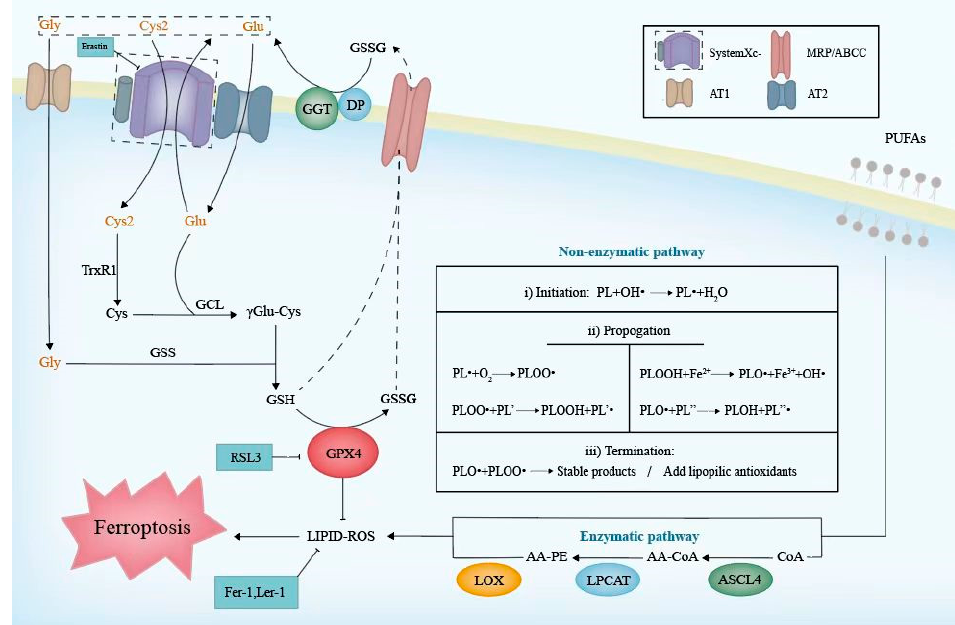
Figure 2. The molecular mechanism of the Cyst(e)ine/GSH/GPX4 axis and lipid peroxidation. The left side of the figure indicates a series of enzymatic reactions for GSH synthesize. As a cofactor for GPX4, GSH could be oxidized to GSSG. Excessive GSH and GSSG could be transported extracellularly. The box on the top right indicates the transporters on the cell membrane. The GPX4 reduces lipid ROS which contributes to the inhibition of lipid peroxidation. The right part depicts the non-enzymatic and enzymatic pathways of lipid peroxidation. The table lists three non-enzymatic phases including initiation, propagation and termination. ACSL, LPCAT3, and LOX are the key enzymes of enzymatic pathways. GSH, glutathione; GCL, γ -Glu-Cys ligase; GSS, glutathione synthetase; MRP/ABCC, multidrug resistance-associated protein; GGT, γ -glutamyl transpeptidase; DP, dipetdase; PUFA, polyunsaturated fatty acid; PLOOH, hospholipid hydroperoxides; PL, phospholipid; PLOO·, peroxyl radical; PLO·, alkoxyl radical; OH·, hydroxide ion; PLOH, phospholipid alcohol; AA, arachidonic acid; PE, phosphatidylethanolamine; ACSL4, acyl-CoA synthetase 4; LPCAT3, lysophosphatidylcholine acyltransferase 3; LOX, lipoxygenase.